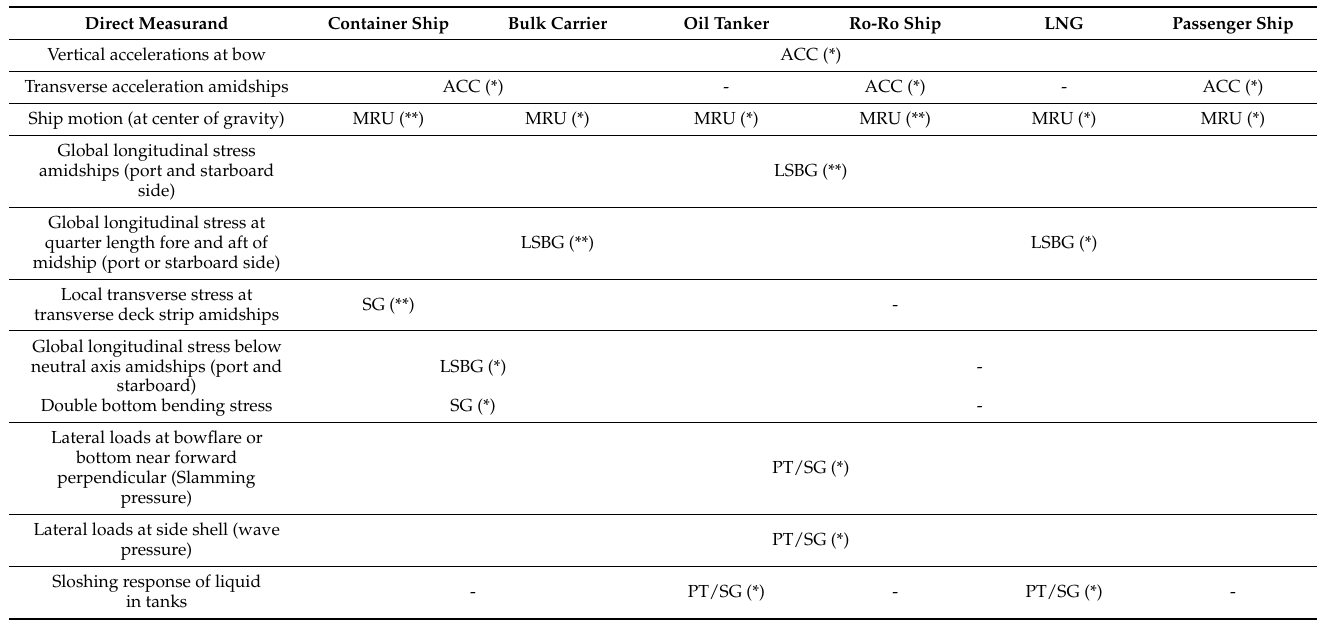
Table 3. Structural sensor for common commercial vessel types